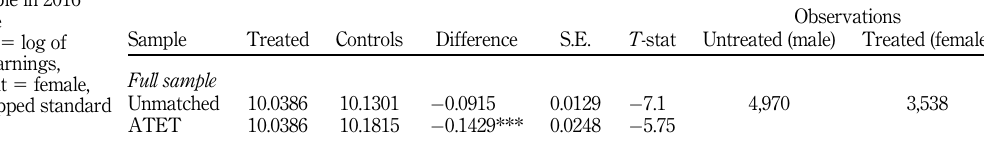
Table 5. ThePSMresultsacross differentsubsamplesin 2010 Table 6. The PSM results for full sample in 2016 (outcome variable 5 log of hourly earnings, treatment 5 female, bootstrapped standard errors)